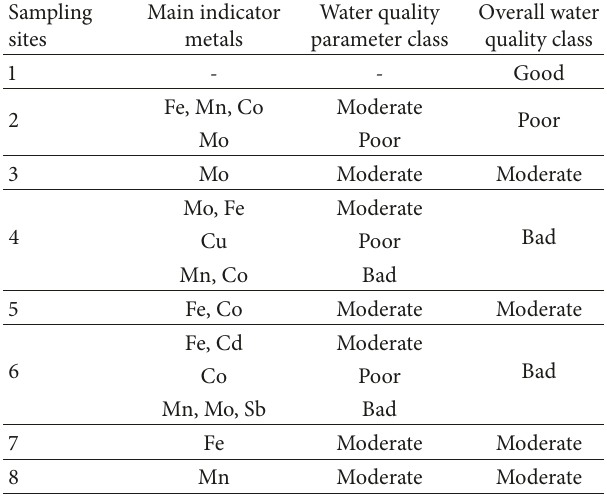
Table6:WaterqualityoftheVoghjiRiverbasinbasedononlyheavy